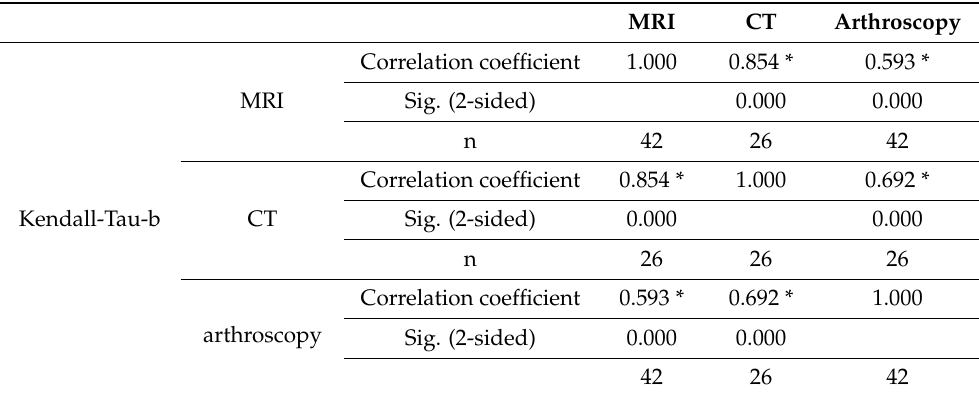
Table 5. Inter-rater correlation between cartilage legion stage in MRI, CT and arthroscopy. MRI CT Arthroscopy Correlation coefficient 1.000 0.854 * 0.593 * Sig. (2-sided) 0.000 0.000 MRI n 42 26 42 Correlation coefficient 0.854 * 1.000 0.692 * Kendall-Tau-b Sig. (2-sided) 0.000 0.000 CT n 26 26 26 Correlation coefficient 0.593 * 0.692 * 1.000 arthroscopy Sig. (2-sided) 0.000 0.000 42 26